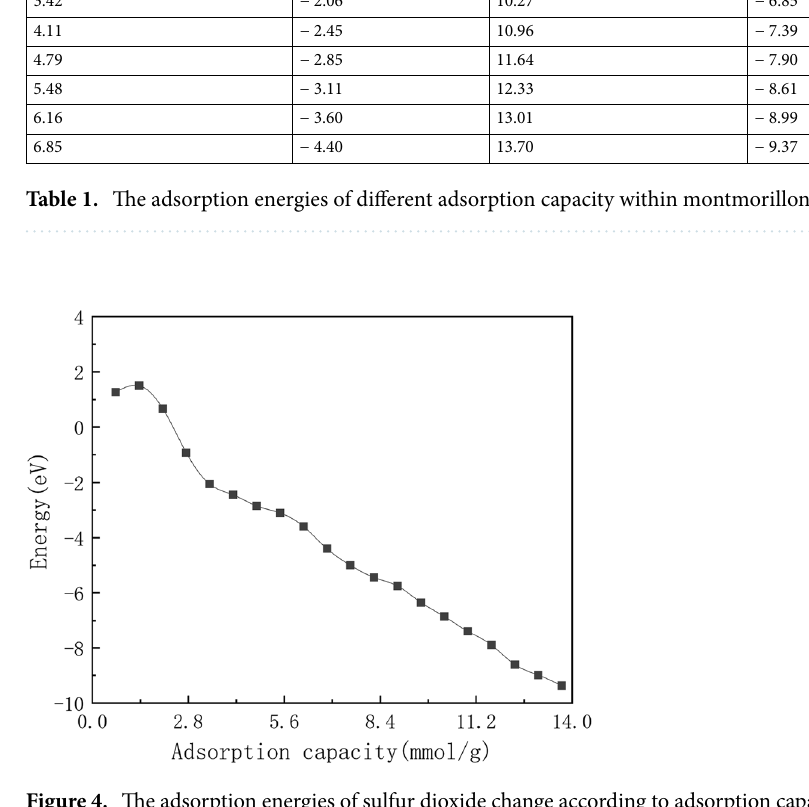
Figure 4. The adsorption energies of sulfur dioxide change according to adsorption capacity.